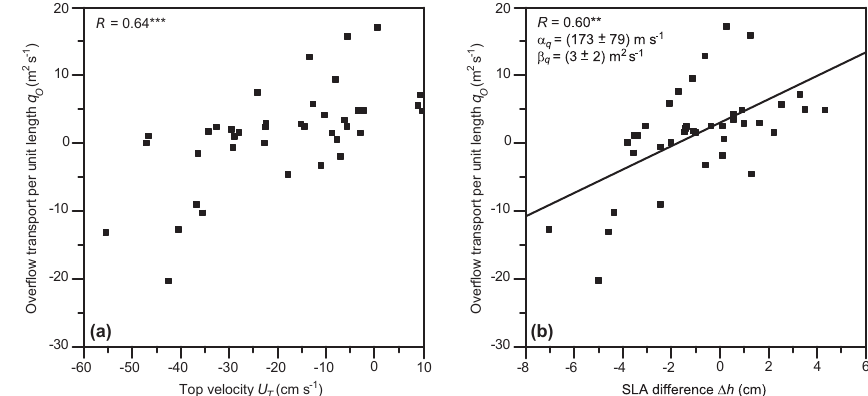
Figure 13. (a) Weekly averaged overflow transport per unit length at site B, q 0 , plotted against weekly averaged top velocity U T . (b) Weekly averaged overflow transport per unit length at site B plotted against weekly averaged difference in SLA values (cid:49)h . The correlation coeffi- cients ( R ) are shown with statistical significance indicated, and in panel (b) also the regression coefficients with uncertainties given by the 95% confidence intervals (Sect. 2.4) and the regression line q 0 = α q · (cid:49)h + β q are shown.